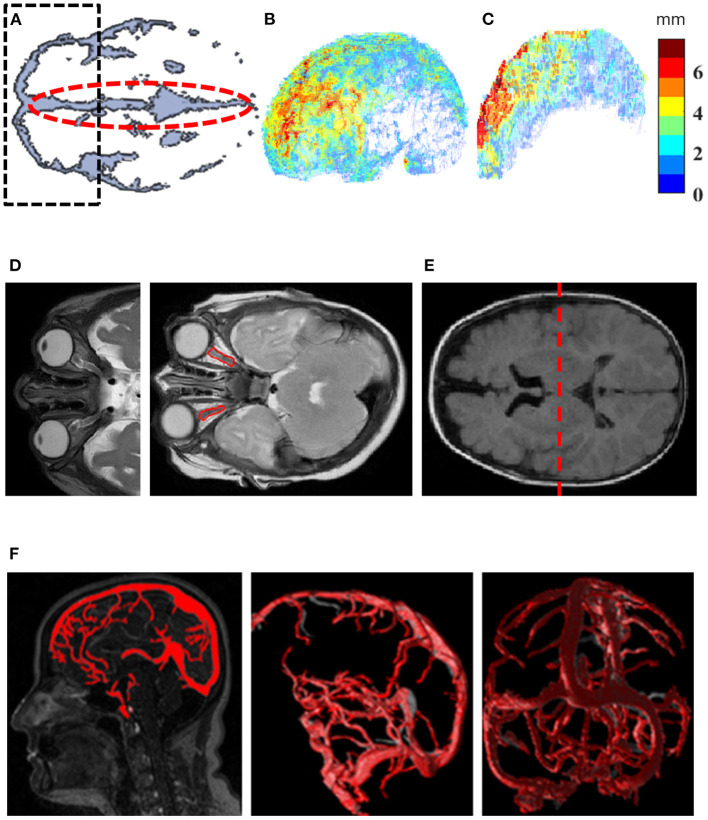
Quantification methods for investigation of imaging markers. (A) An axial view at the level of the Sylvian fissure was used to create a region of interest (ROI) for frontal SAS (black dashed line) and an ROI for interhemispheric fissure (red dashed line). The ROI from A was extruded along axis Z in order to create a 3D mask for the frontal SAS. (B) 4D visualization of SAS width map, where each voxel on the most outer surface of the SAS is characterized by its 3D position and assigned a width value (jet color-scale). (C) 4D visualization of interhemispheric width distribution on the mid-surface of the interhemispheric fissure. Each voxel is characterized by its 3D position and assigned a width value (jet color-scale). (D) Optic nerve deformity characterization (red contour). (E) Dividing the LV into anterior and posterior compartments (red dashed line) in the middle of the ventricular body along the Z axis to extract initial LV volume from CSF. (F) Automated algorithm for quantification of cross-sectional vessel alterations was used for characterization of the venous sinus system anatomy. CSF, cerebrospinal fluid; LV, Lateral ventricle; SAS, subarachnoid space.